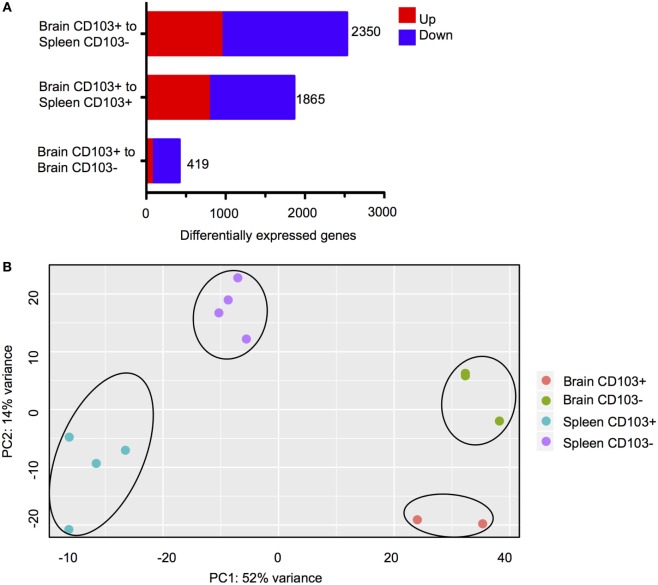
Transcriptional characteristics of brain CD103+ CD8 T cells. CD8 T cells were isolated from the brain and spleen of chronically infected mice and sorted according to CD103 expression. (A) Differentially expressed genes (DEGs) for the three indicated analyses. Numbers indicate combined upregulated and downregulated DEGs with fold change >2 and FDR <5%. (B) PCA plot for normalized read counts (reads per kilobase of transcript per million mapped reads) for all samples.